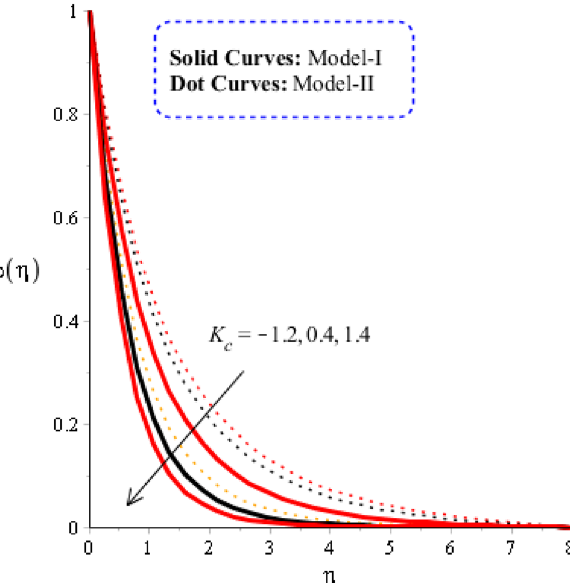
Figure 12. Graphical impact of K c on concentration distribution when α = 0.5, m = 0.3, Re = 4.0, we = 3.0, M = 3.0, Pr = 206, H t = − 2.0, Sc = 0.0, δ 1 = 0.4, ϕ 1 = 0.003, ϕ 2 = 0.004, ϕ 3 =